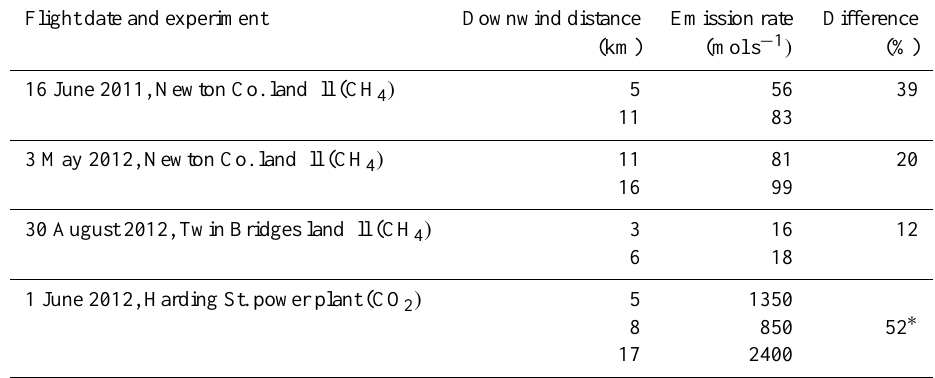
Table 3. Percentage difference between estimated emission rate from two or more downwind distances for four flight